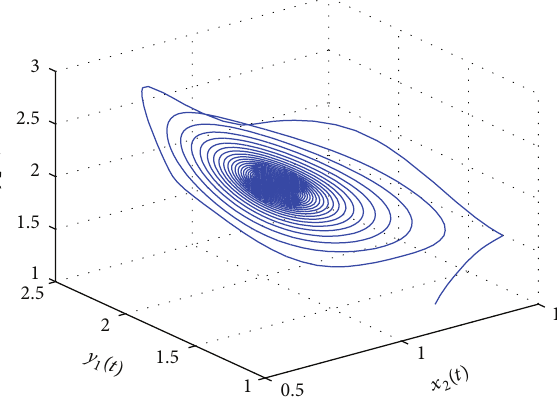
Figure 20: The phase plot of the states 𝑥 1 , 𝑥 2 , 𝑦 2 for 𝜏 2 = 5.5500 < = 6.6494 and 𝜏 ∗ = 2.5000 . 𝜏 ∗ 2 1